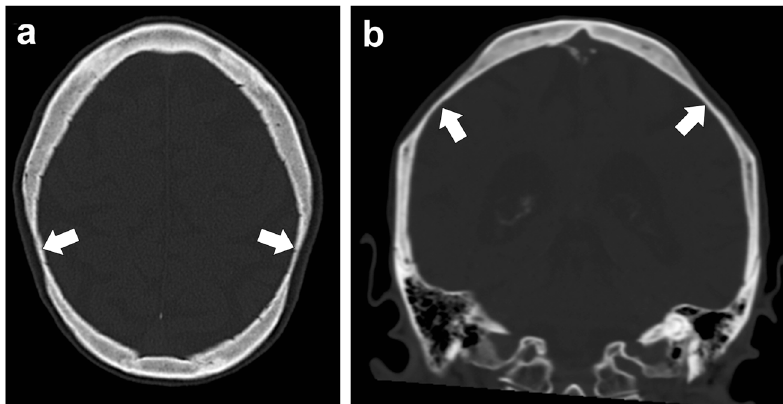
Fig. 26 Parietal thinning. Axial ( a ) and coronal ( b ) head CT images shows thinning of the parietal bones ( thick arrows